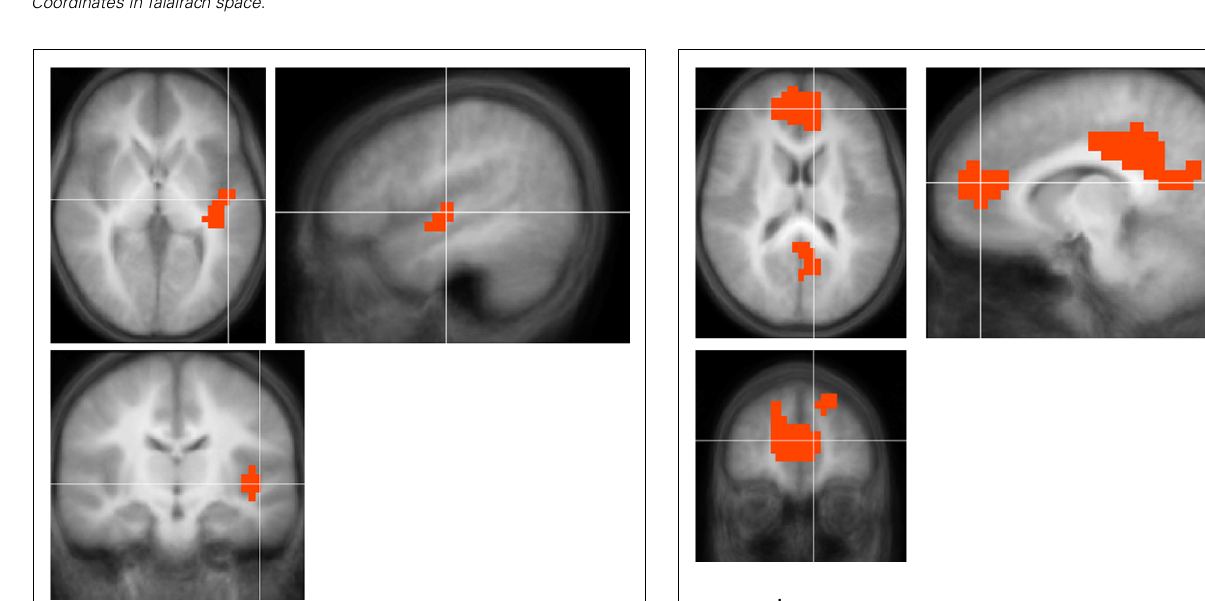
FIGURE 3 | Regions with significantly smaller functional deactivation in children with unilateral hearing loss for the fMRI audio–visual paradigm of a modified “TokenTest” (described in more detail in the text) compared to normal-hearing controls. Images in radiologic orientation. Slice locations (Talairach coordinate system): Z = + 16 mm (Axial); X = − 9 mm (Sagittal); Y = + 47 mm